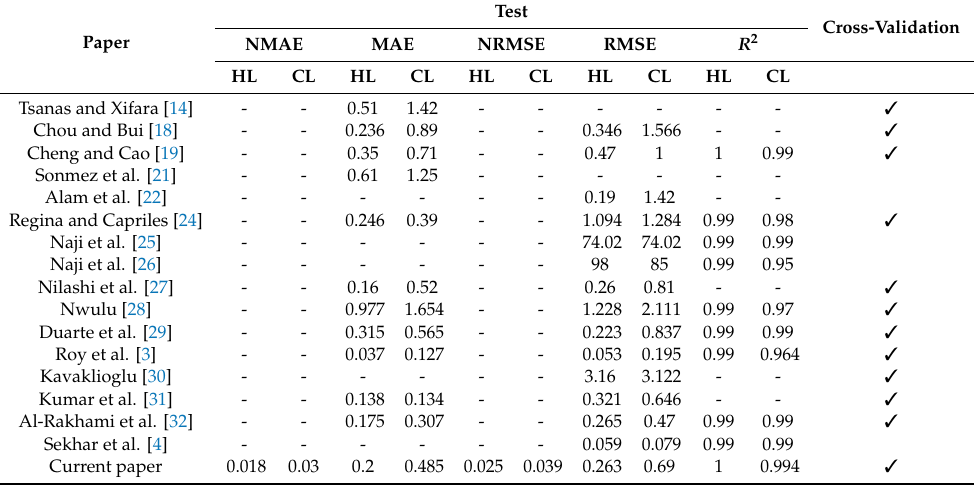
Table 7. Comparison of performance measures in testing data. “NMAE” stands for normalized MAE and “NRMSE” stands for normalized